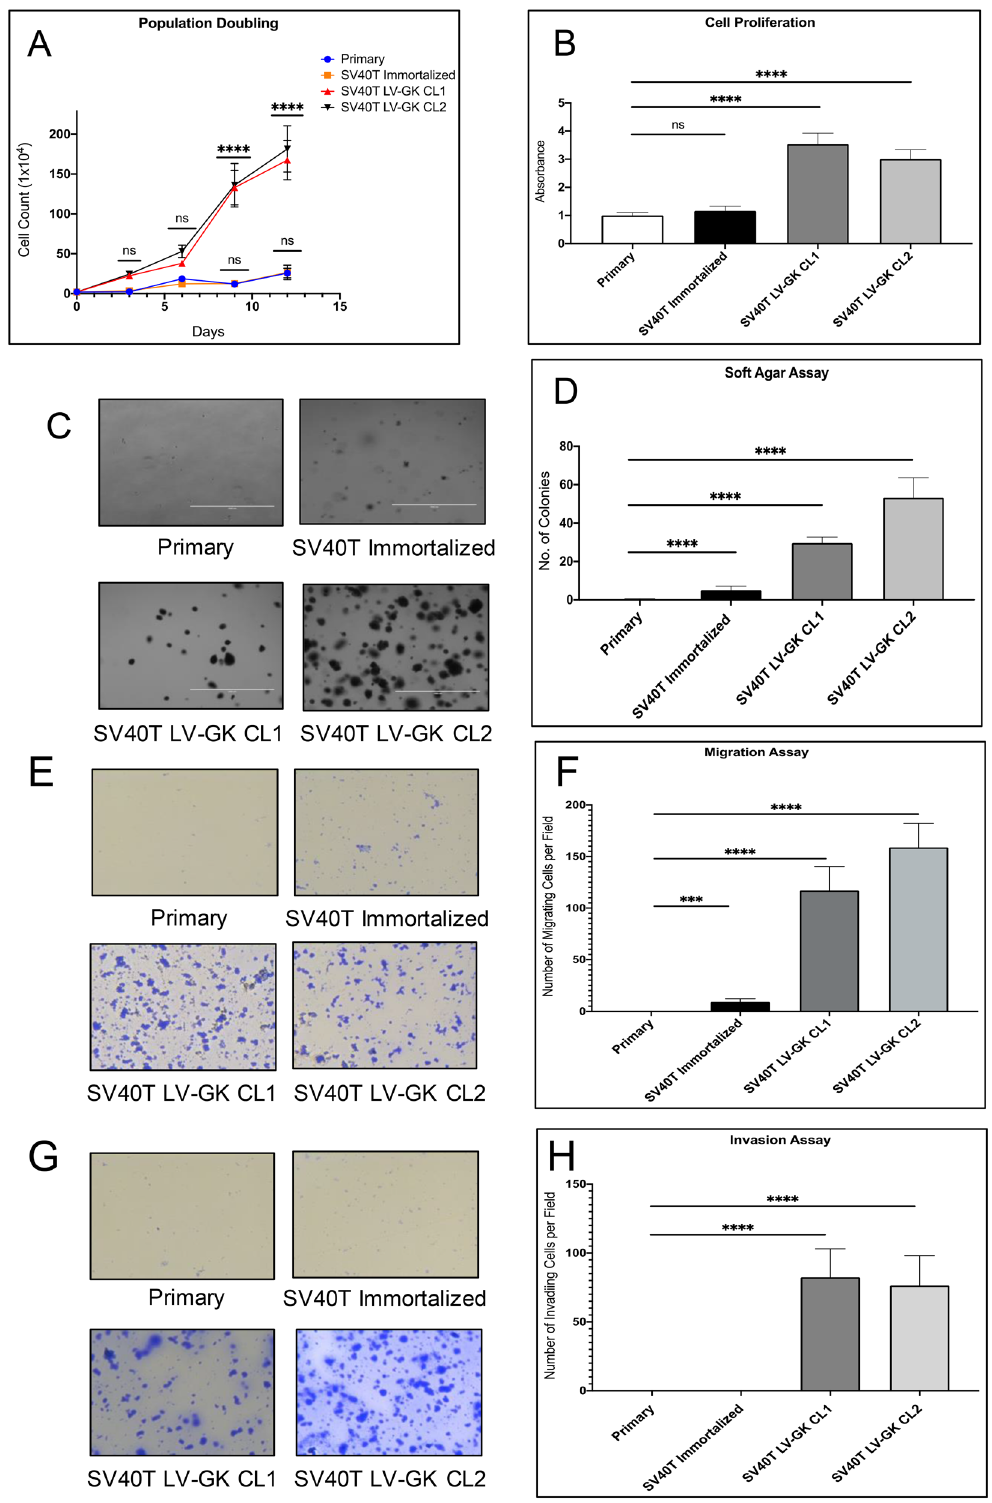
Figure 2. In vitro cell transformation assays. Cultured primary epithelial cells from porcine pancreatic duct were compared with SV40T immortalized and transformed (SV40T + KRAS G12D ) cell lines. ( A ) Cell culture population doubling time (count-based analysis). ( B ) Proliferation rate using metabolic dye assay, represented as fold change with respect to primary cells (defined as 1). ( C ) Phase contrast images of soft agar assay (bar = 1000 µm). ( D ) Plot of soft agar assay. ( E – F ) Transwell migration assay (absence of BME), phase images and plot. ( G – H ) Transwell invasion assay (presence of BME), phase images and plot. Each bar or data point in this Figure represents the mean ± SD of triplicate wells; each experiment performed three times on separate days (one representative experiment shown in each panel); ****p < 0.0001; ns = not significant (p ≥